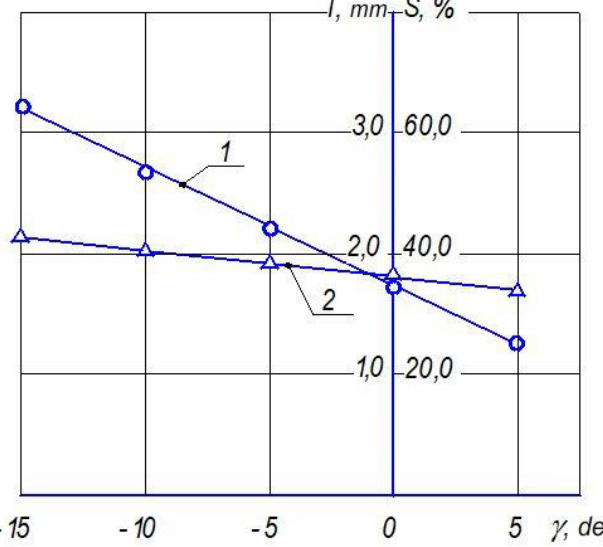
Fig. 12. Dependence of the brass coverage area of the contact surface S (curve 1) and the contact length l (curve 2) on the angle γ when modeling micro-cutting with a SCh20 cast iron cutter with a brass surface